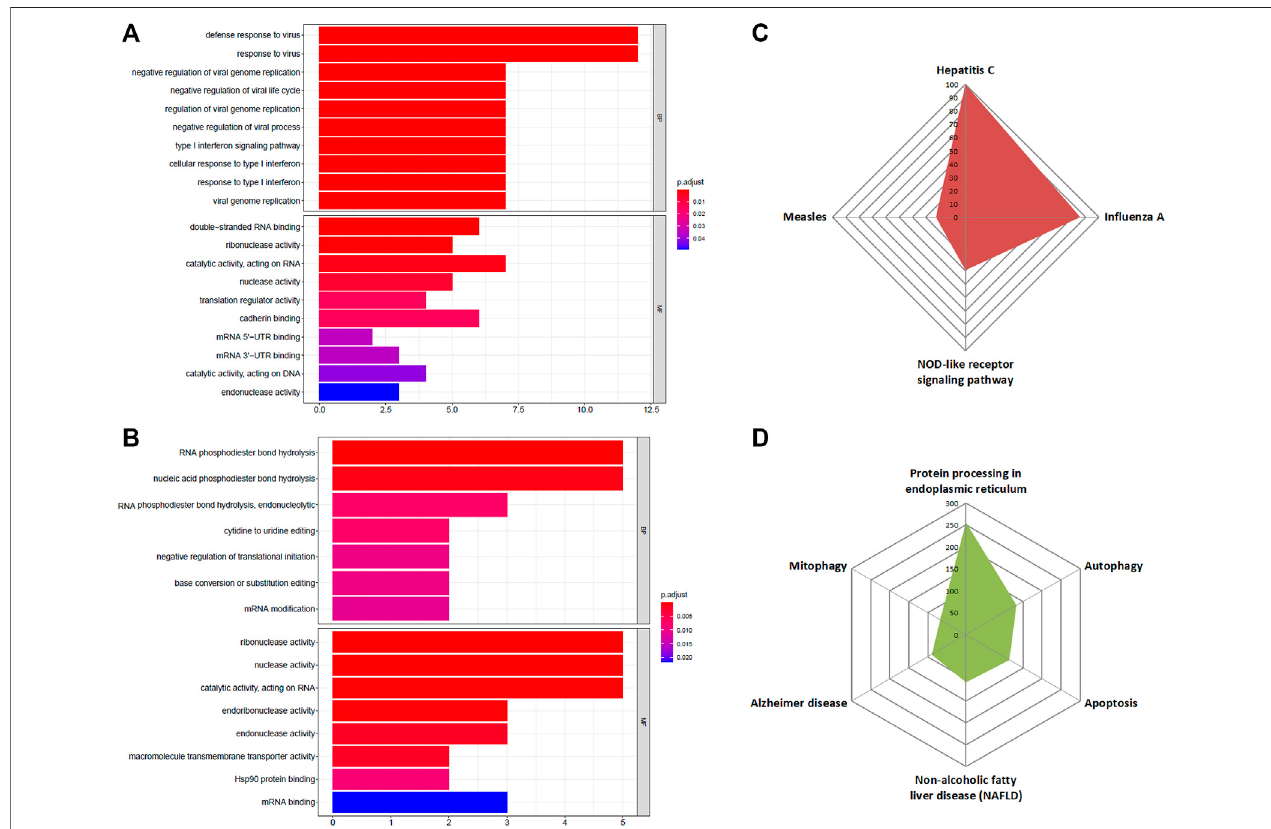
FIGURE3| GOand KEGGenrichmentanalysisofDE-RBPs. (A) Barplot showsenriched GOtermsofupregulated RBPs, (B) barplot showsenriched GOtermsof downregulated RBPs, (C) radar plot represents the KEGG pathway analysis result of upregulated RBPs, (D) radar plot represents the KEGG pathway analysis result of downregulated RBPs. BP: biological processes, MF: molecular